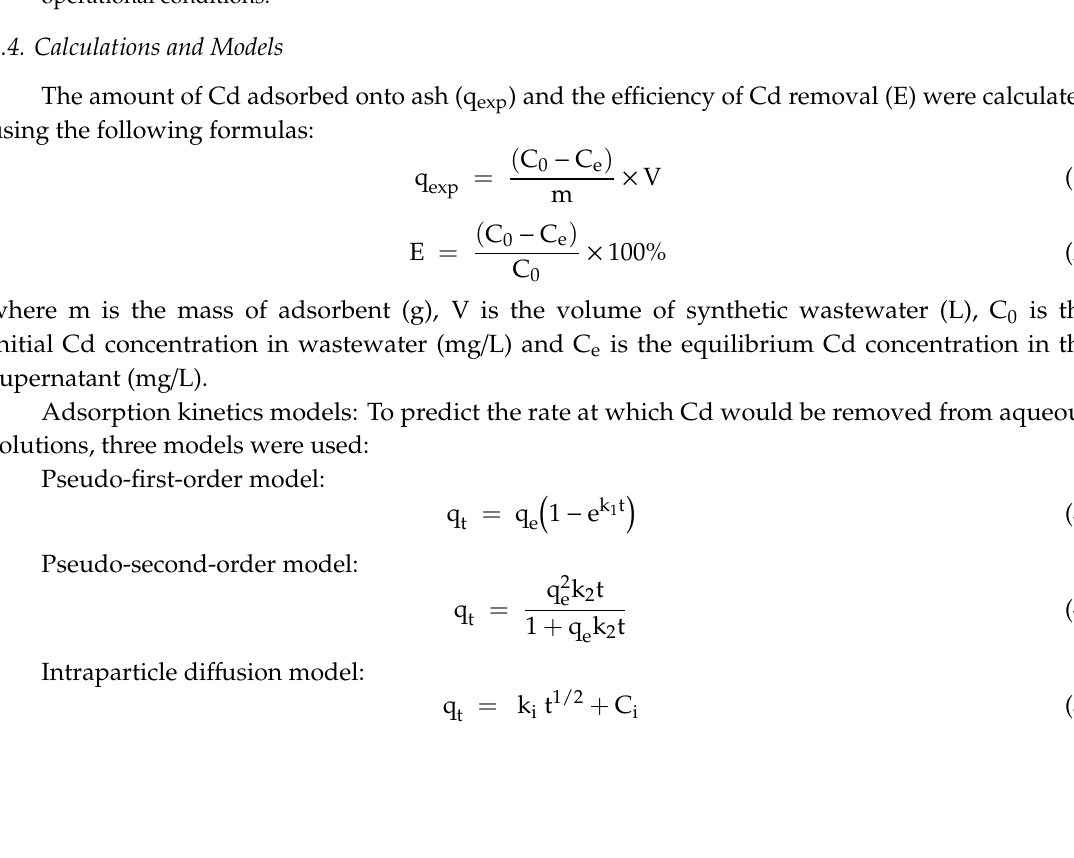
Figure 2. Batch experiments for investigating Cd adsorption onto poultry ash under different operational conditions.